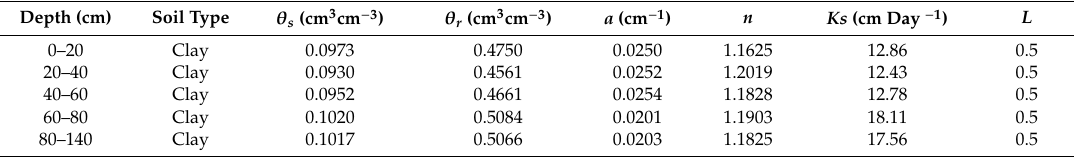
Table 3. Optimized value of soil hydraulic